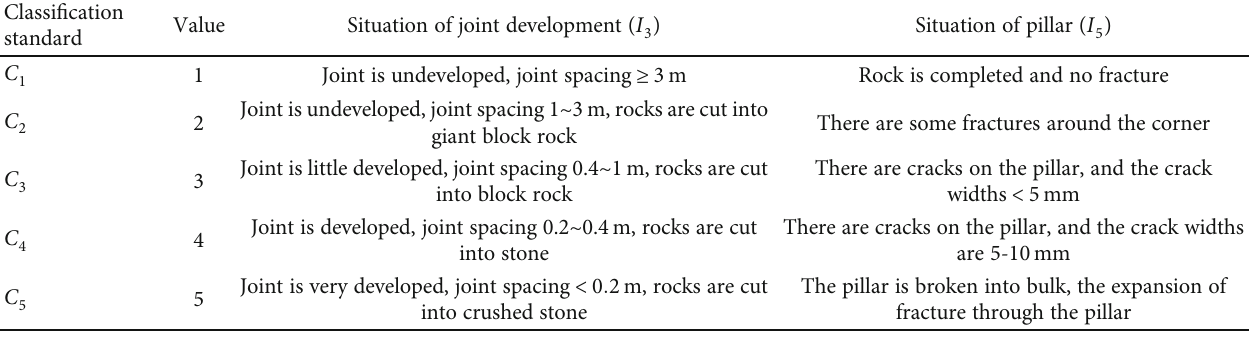
Table 2: Classi fi cation criterion of qualitative indices.